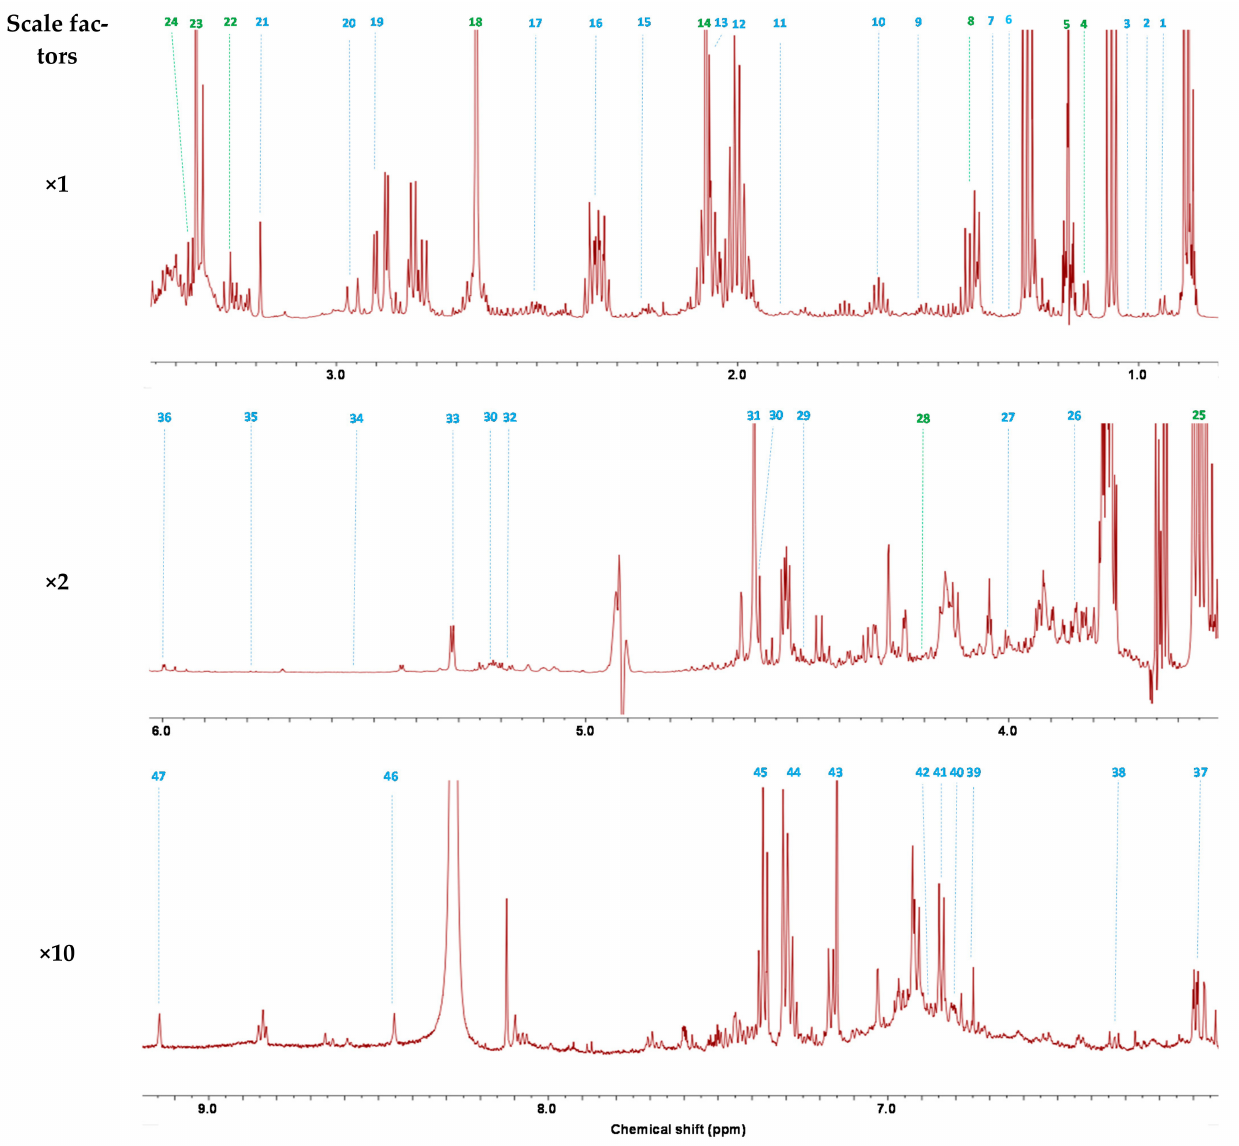
Figure 1. Typical 1 H-NMR spectrum of wine after water and ethanol suppression (NOESYGPPS1D sequence). Identified constituents are listed in Table 1 (compounds in green are quantified on the ZGPR